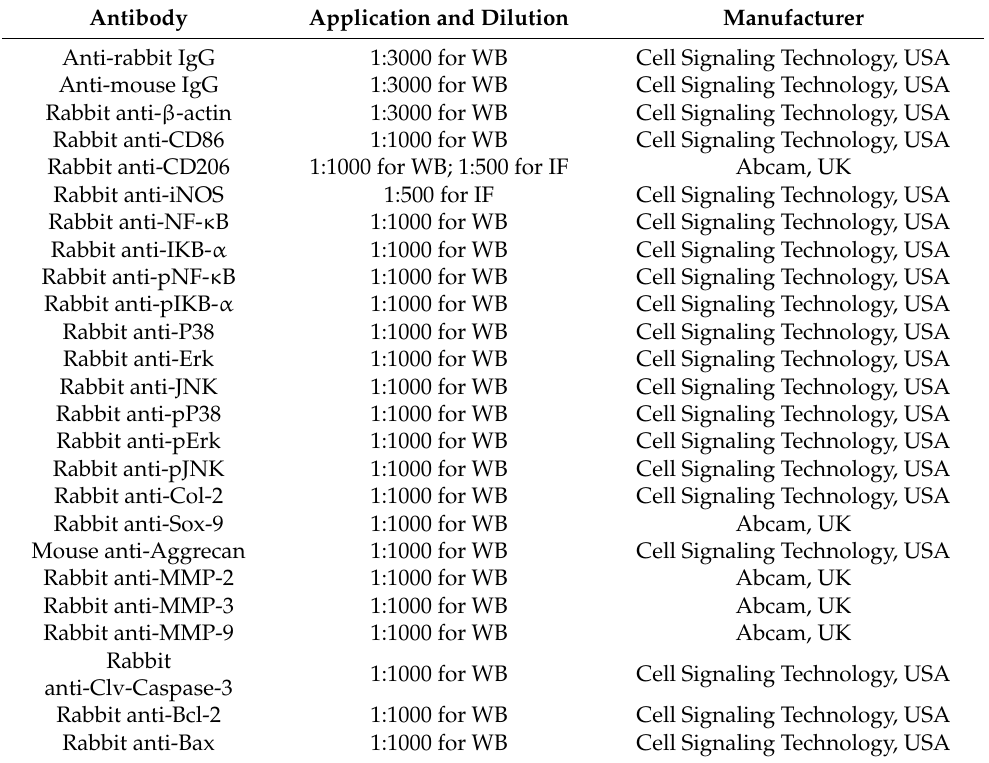
Table 2. Antibodies used for Western blot (WB) and immunofluorescence